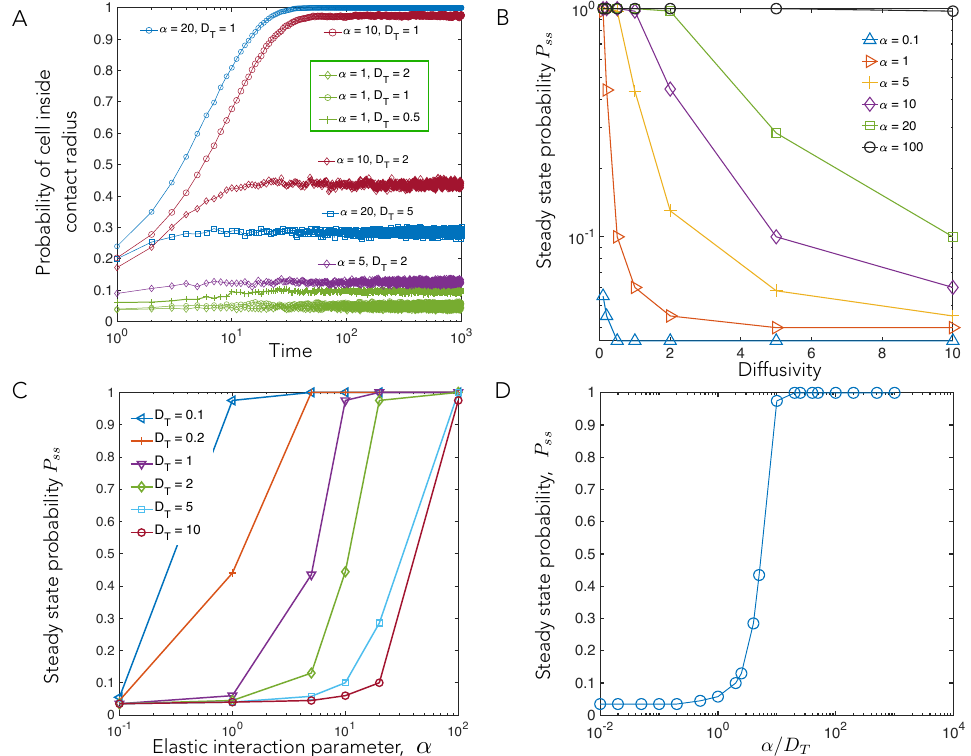
Elastic interaction parameter, <latexit sha1_base64="W4NsZ3UdMd3JSqHJ0nbSZyXsADw=">AAAB7XicbVDLSgNBEOz1GeMr6tHLYBA8hV0R9Rj04jGCeUCyhN7JbDJmdmaZmRVCyD948aCIV//Hm3/jJNmDJhY0FFXddHdFqeDG+v63t7K6tr6xWdgqbu/s7u2XDg4bRmWasjpVQulWhIYJLlndcitYK9UMk0iwZjS8nfrNJ6YNV/LBjlIWJtiXPOYUrZMaHRTpALulsl/xZyDLJMhJGXLUuqWvTk/RLGHSUoHGtAM/teEYteVUsEmxkxmWIh1in7UdlZgwE45n107IqVN6JFbalbRkpv6eGGNizCiJXGeCdmAWvan4n9fObHwdjrlMM8sknS+KM0GsItPXSY9rRq0YOYJUc3croQPUSK0LqOhCCBZfXiaN80pwWfHvL8rVmzyOAhzDCZxBAFdQhTuoQR0oPMIzvMKbp7wX7937mLeuePnMEfyB9/kDjSePHQ==</latexit> ↵ Figure 6. Capture statistics of motile cell. ( A ) Probability that cell B is inside contact radius as a function of time. ( B , C ) The dependence of steady state capture probability, P ss , i.e., the fraction of cells captured within the contact radius after a long time interval, on simulation parameters. ( B ) shows the dependence on diffusivity, D T at different values of the elastic interaction parameter, α , whereas ( C ) shows the dependence on α for different values of D T . ( D ) The steady state capture probability, P ss , data can be collapsed into a single master curve, when plotted vs. the key parameter, alpha / D T , the strength of the elastic interactions relative to the diffusivity. This is expected since our model steady state is a thermal equilibrium with the effective temperature set by the noisy cell motility, D T , and the competition between attractive interactions and noise dictates the number of cells (cell trajectories) captured vs. the number that